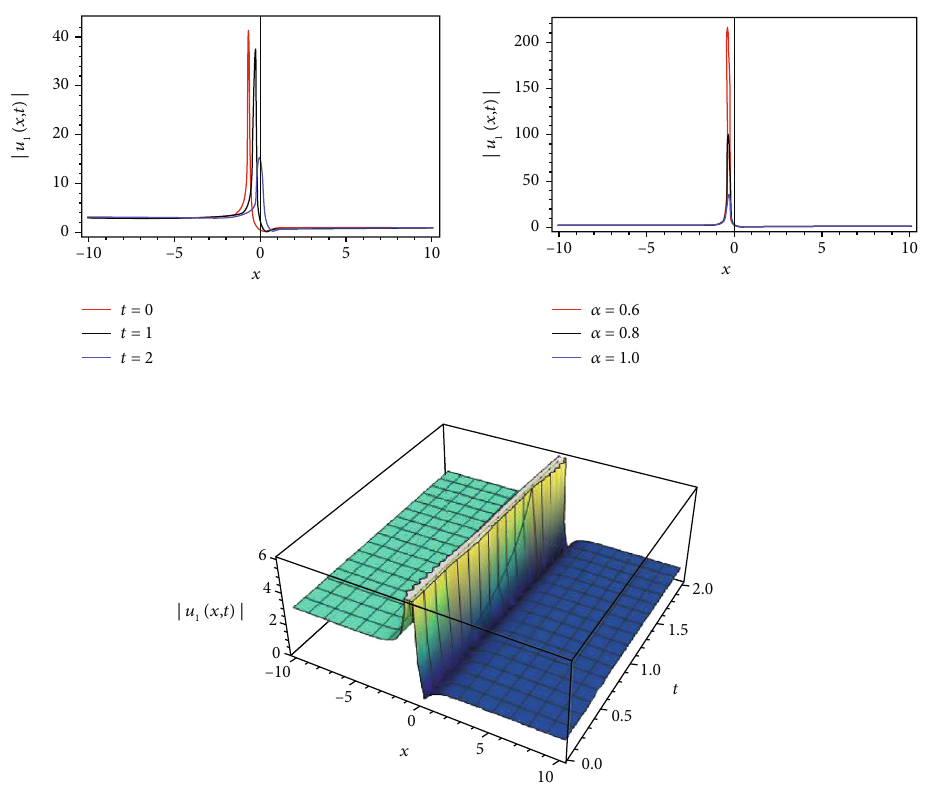
Figure 6: 2D and 3D graphics of Case 2 for hyperbolic traveling wave solution (39) at f α = 0 : 6, k = 1 : 5, q = 1, s = 1, c = 0 : 5, λ = 1 g